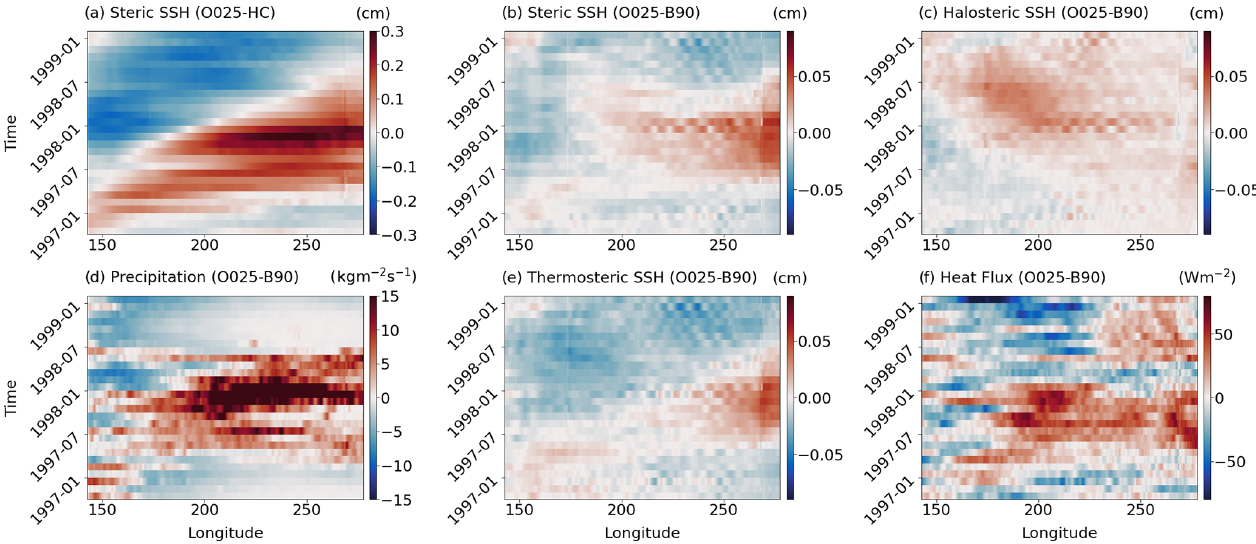
Figure 9. Hovmöller diagram at the Equator. (a) Anomalies of steric SSH from O025-HC and anomalies from O025-B90 of (b) steric SSH, (c) halosteric SSH, (d) precipitation, (e) thermosteric SSH and (f) net downward heat